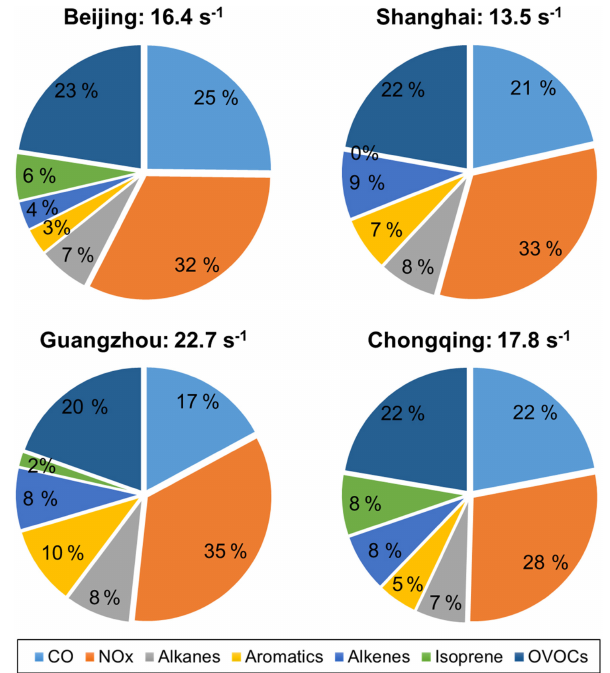
Figure 4. Contributions of different atmospheric constituents to the OH reactivity in Beijing, Shanghai, Guangzhou, and Chongqing. The OVOC contributions were simulated using a box